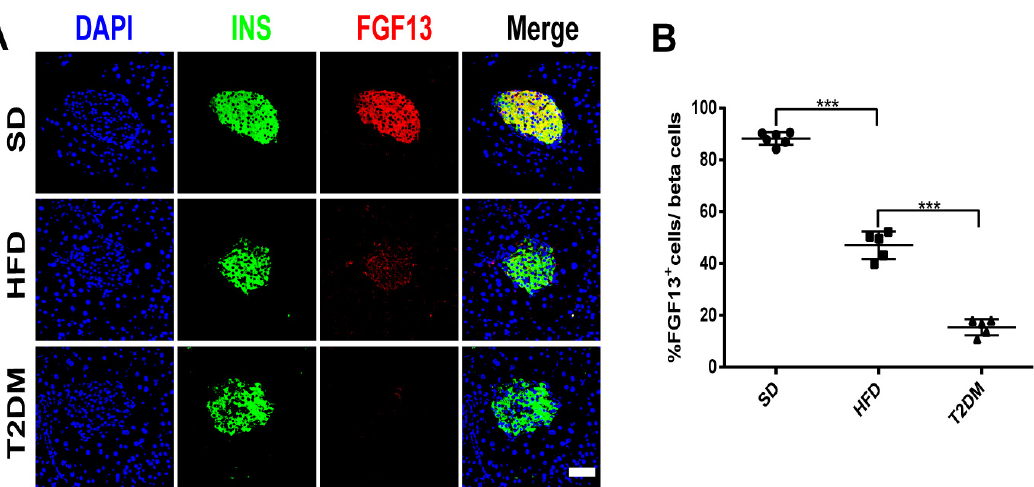
Figure 6. The expression levels of FGF13 in islets of mouse models of pre ‐ diabetes and T2DM. ( A , B ) Representative immunofluorescent images of insulin and FGF13 in the pancreatic islets ( A ) and the ratio of double immunopositive cells ( B ). Scale bars = 20 μ m. Values are expressed as means ± SD ( n = 5 or 6). *** p < 0.001.